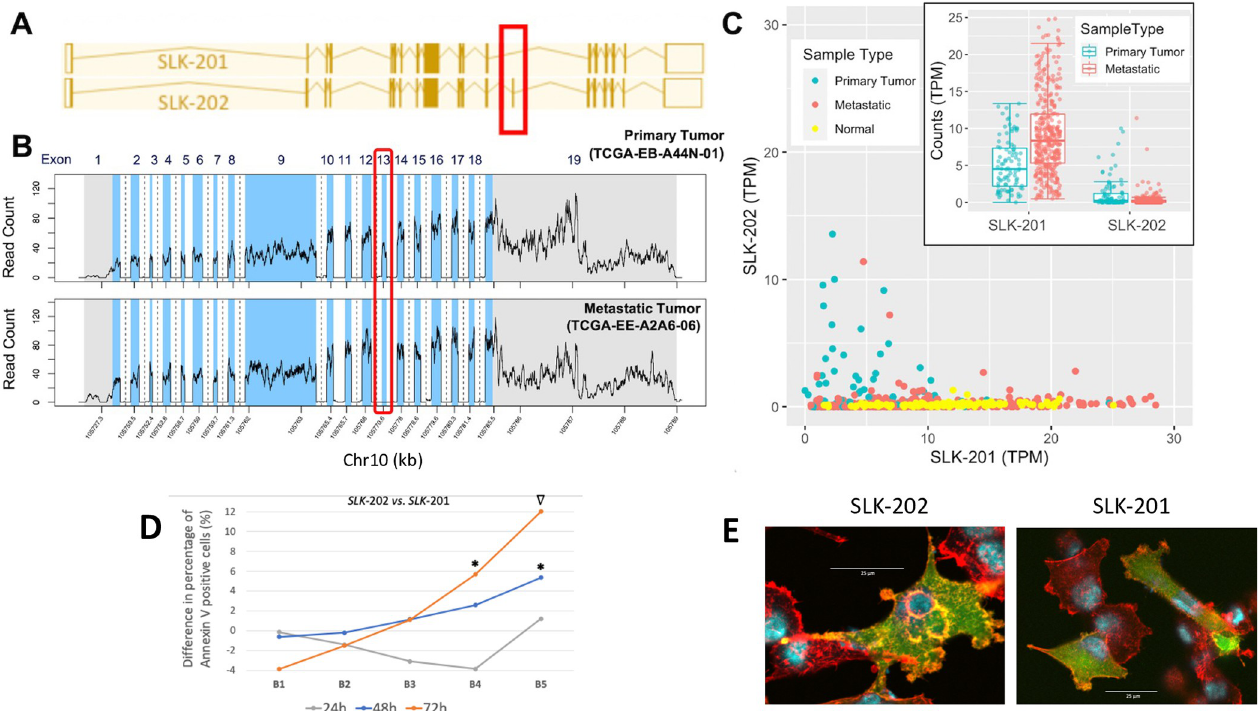
Fig 7. Alternative splicing in SLK . (A) The two coding isoforms of SLK , which only differ in the presence or absence of exon 13. (B) Mapped read counts from one primary tumor and one metastatic sample. In the metastatic sample, no reads are mapped to exon 13, indicating that isoform SLK -202 is not present; exons (blue), introns (white-dashed bar indicates introns longer than 300 bp, only partially shown), UTRs (gray). (C) Box and scatter plots for the two isoforms of SLK . Also shown in the scatter plot are the normal melanocyte samples from Zhang et al. [53]. (D) Difference in incidence of annexin V positive cells between SLK -202 (long) and SLK -201 (short) isoforms for bins, B1-B5, of increasing GFP fluorescence (see also S7A Fig) and different time points. Each value represents the average of two replicates (actual values and associated variance are provided in S7B–S7F Fig); � (p < 0.05), r (p = 0.055). (E) Merged channel images of A375 cells transfected with eGFP-only, SLK -202-eGFP, and SLK -201-eGFP constructs at the 24-hour timepoint. Cells were stained with DAPI (blue) and phalloidin (red), along with GFP expression (green). Scale bars = 25 μ m.